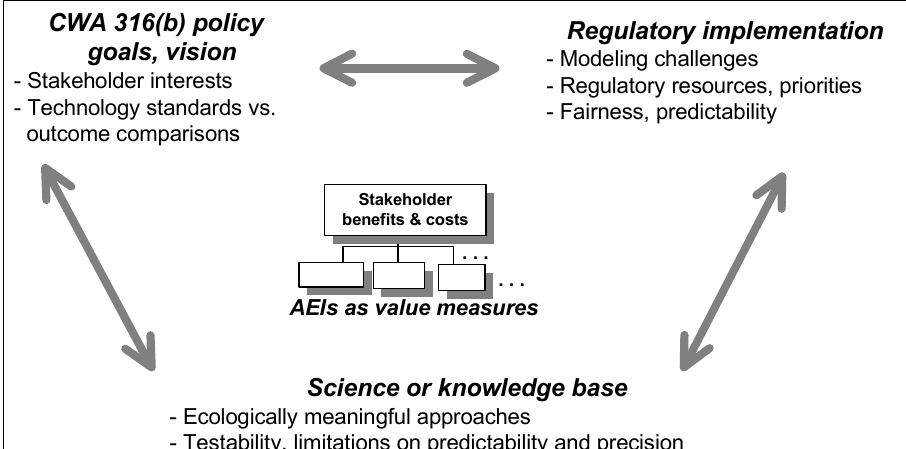
FIGURE 2. Comparative framework for evaluating AEI and 316(b) policy